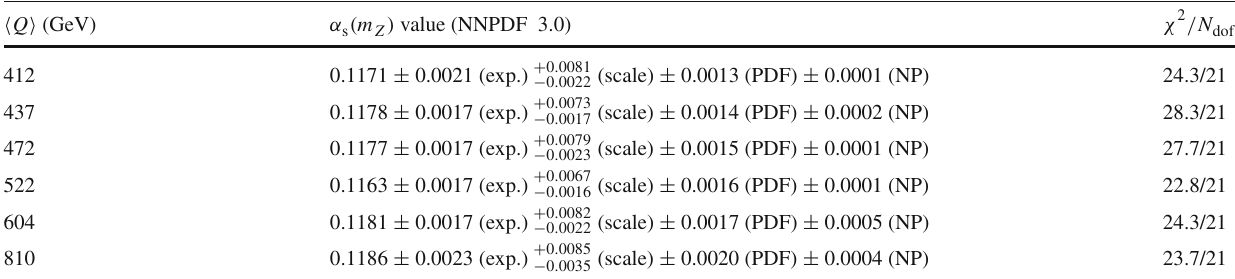
column, while the values of the χ 2 function at the minimum are shown in the third column. The uncertainty referred to as NP is the one related to the non-perturbative